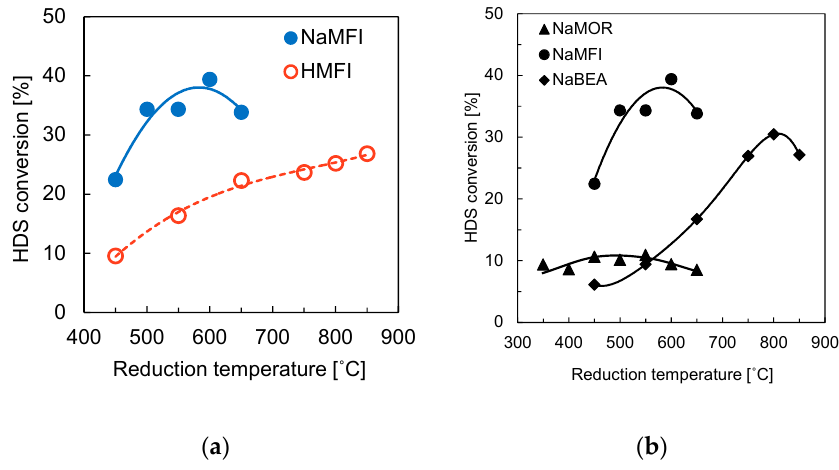
Figure 7. Effect of the reduction temperature and zeolite type on the HDS conversion of thiophene: ( a ) Effect of the addition of Na to the zeolite (Printed with the permission of ([33]; Copy right Elsevier); ( b ) Different types of zeolites (printed with permission of [34]).